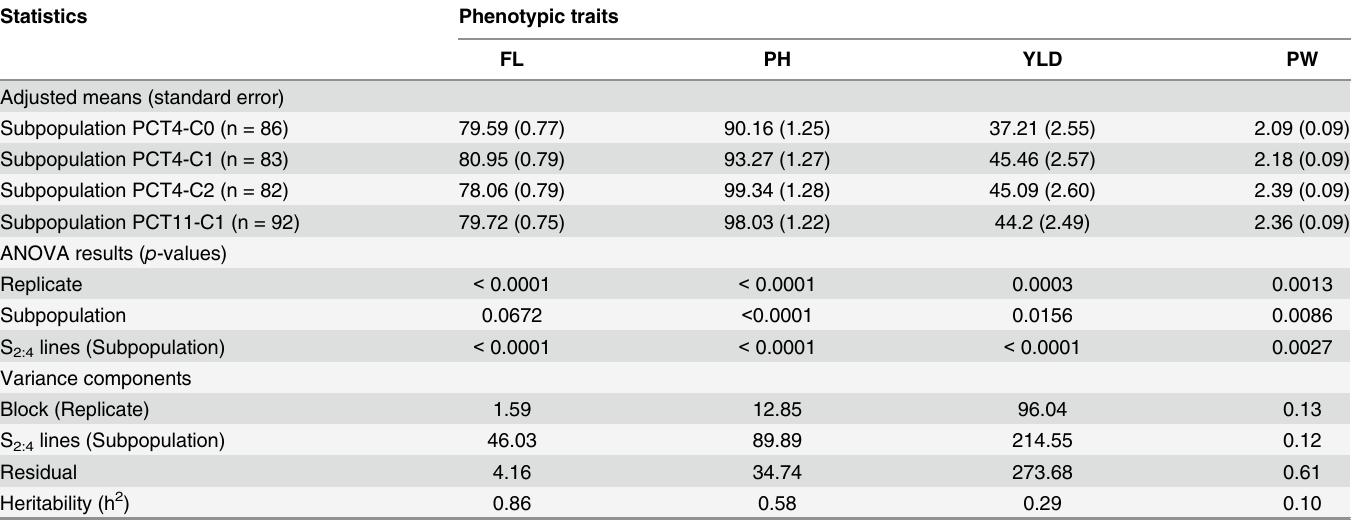
Table 1. Summary statistics of the four phenotypic traits, ANOVA results and heritability on phenotypes of the 343 S 2:4 lines extracted from four